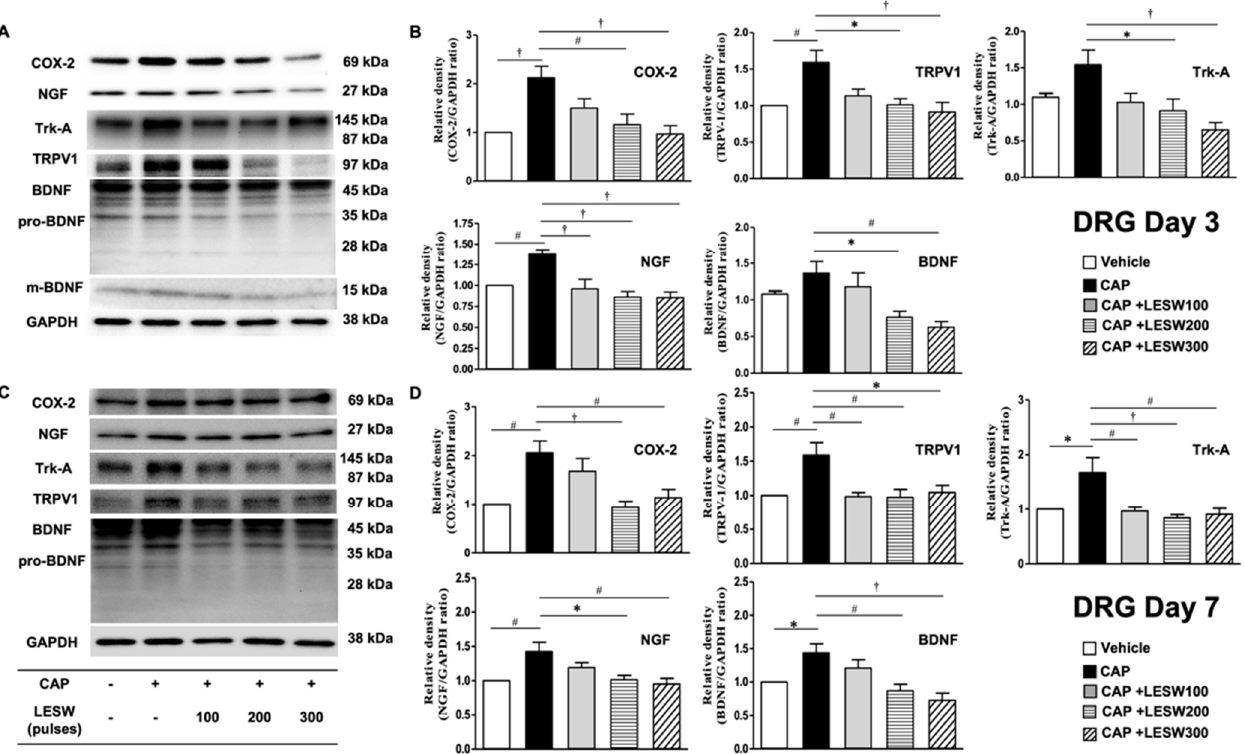
Figure 4. ( A , C ) Western blot for detecting COX-2, NGF, Trk-A, BDNF, and TRPV1 expression in the L6 DRG on day three and day seven after intraprostatic capsaicin injection. ( B , D ) All inflammatory molecules, neurogenic growth factors and receptors were upregulation (solid black bar) on day three and day seven. Li-ESWT significantly suppressed COX-2, NGF, Trk-A, BDNF, and TRPV1 expression in a dose-dependent manner. ( n = 10 per group; * p < 0.05; # p < 0.01; † p < 0.001).